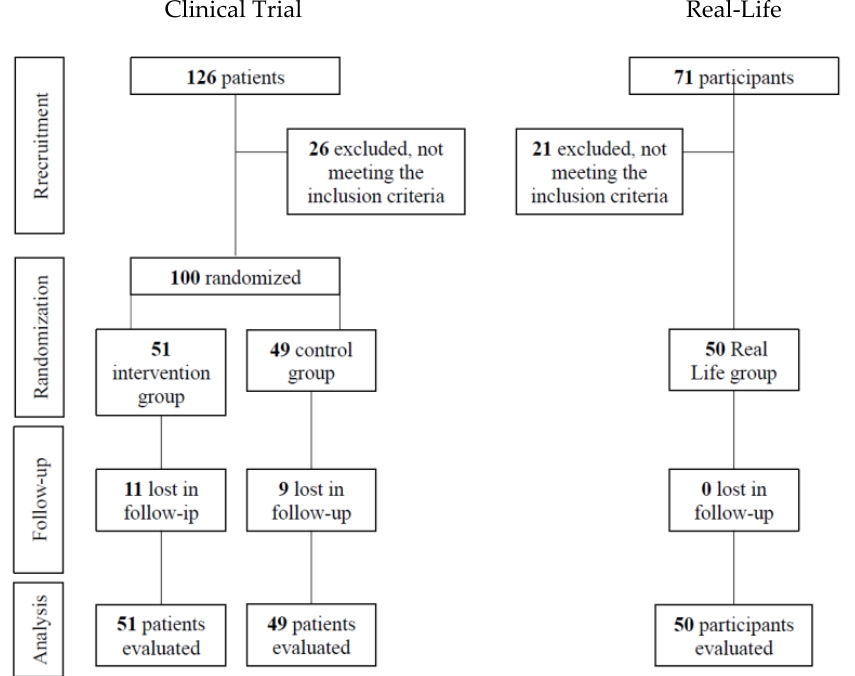
Figure 1. Flow diagram of the participants.